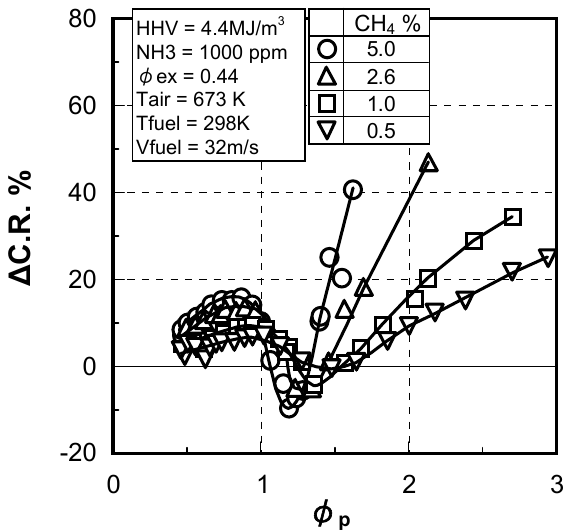
Figure 21. Effect of CH concentration on difference in conversion rates between each 4 case of fuel including methane and that including no methane in two-stage combustion. Data in Figure 17 was